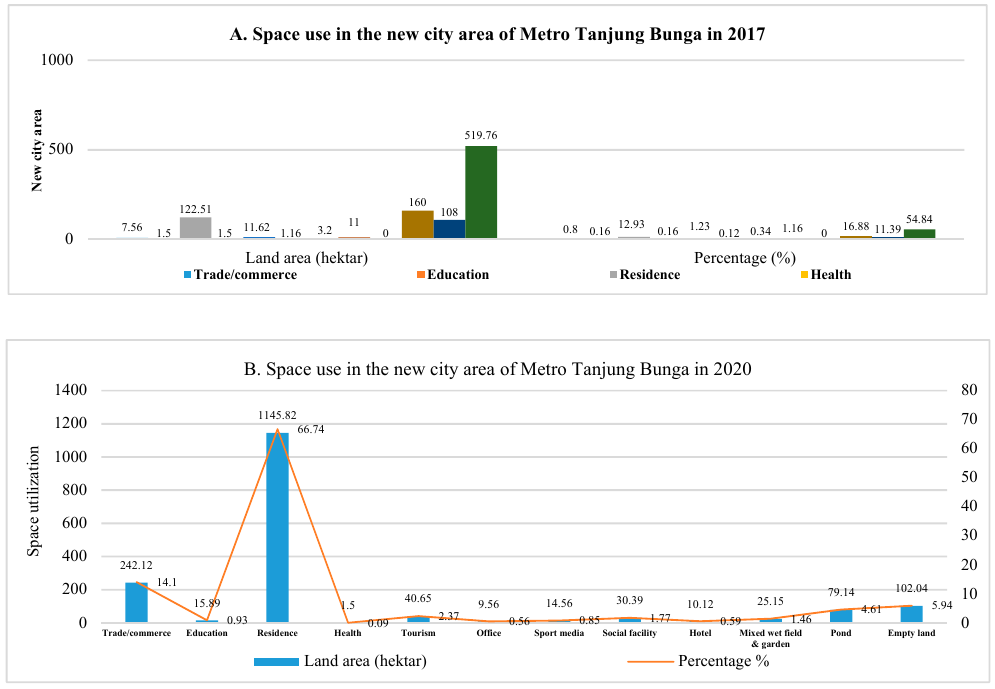
Figure 10. ( A , B ) Utilization of the new city area Metro Tanjung Bunga in 2017–2020. Source: Author elaborator and Google Maps @ .